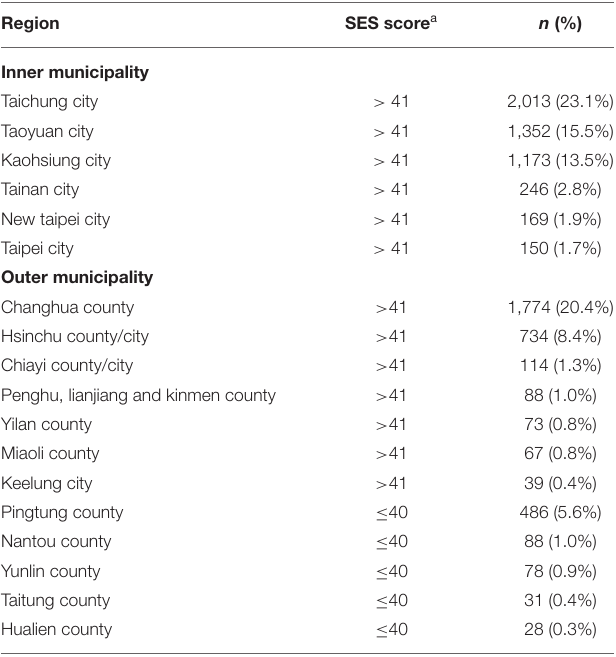
TABLE 1 | Geographic and economic distribution of respondents to the online SOSC-COVID-19 survey in Taiwan ( N = 8,703). Region SES score a Inner municipality